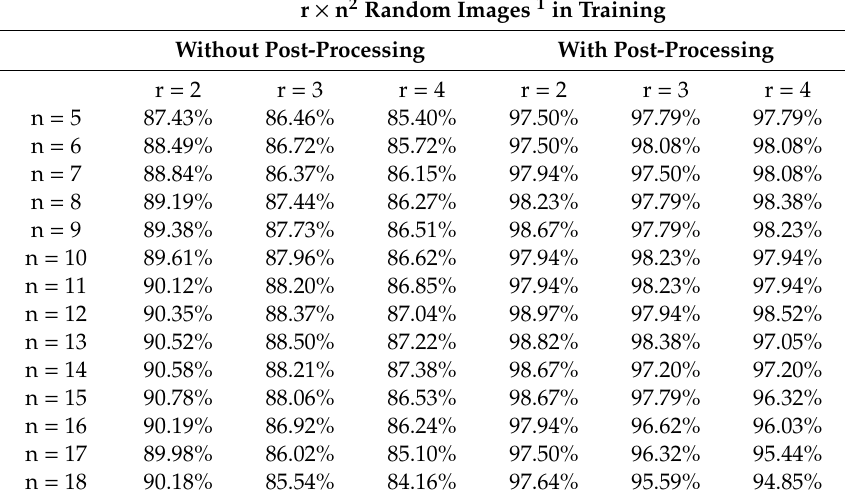
Table 5. Classification results of the experiment on the Outex database for the set of 68 images. The best results reached with and without post-processing are highlighted by bold text.